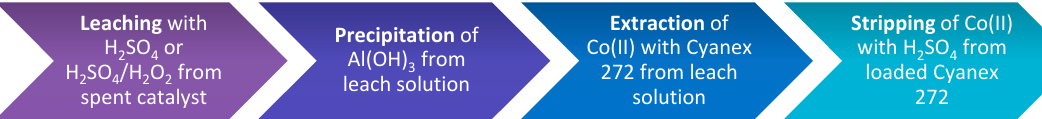
Figure 1. Four-step process for hydrometallurgical recovery of Co(II) from CoMo catalyst of hydrodesulfurization.